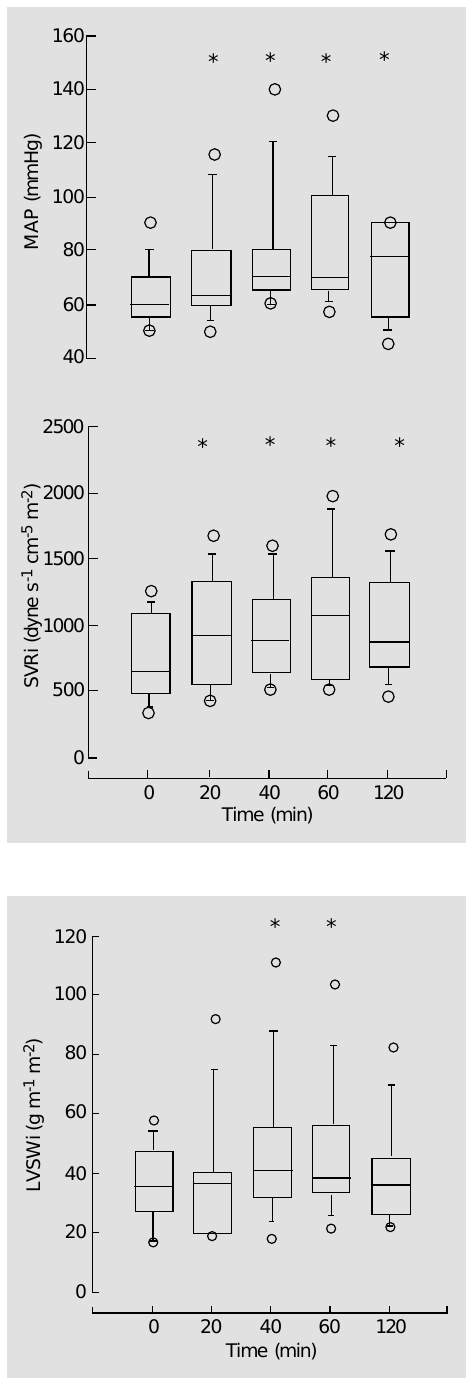
Figure 1 - Time course of mean arterial pressure (MAP) (top) and systemic vascular resistance in- dex (SVRi) (bottom) after intra- venous administration of meth- ylene blue (4 mg/kg) after baseline (time 0) in 10 septic shock patients. Mean arterial pressure significantly increased from baseline at 20, 40, 60 and 120 min (*P<0.05 compared to time 0). The box plot lines indi- cate the median and the 25th and 50th percentiles and error bars indicate the 10th and 90th percentiles. The circles indicate the extreme values.